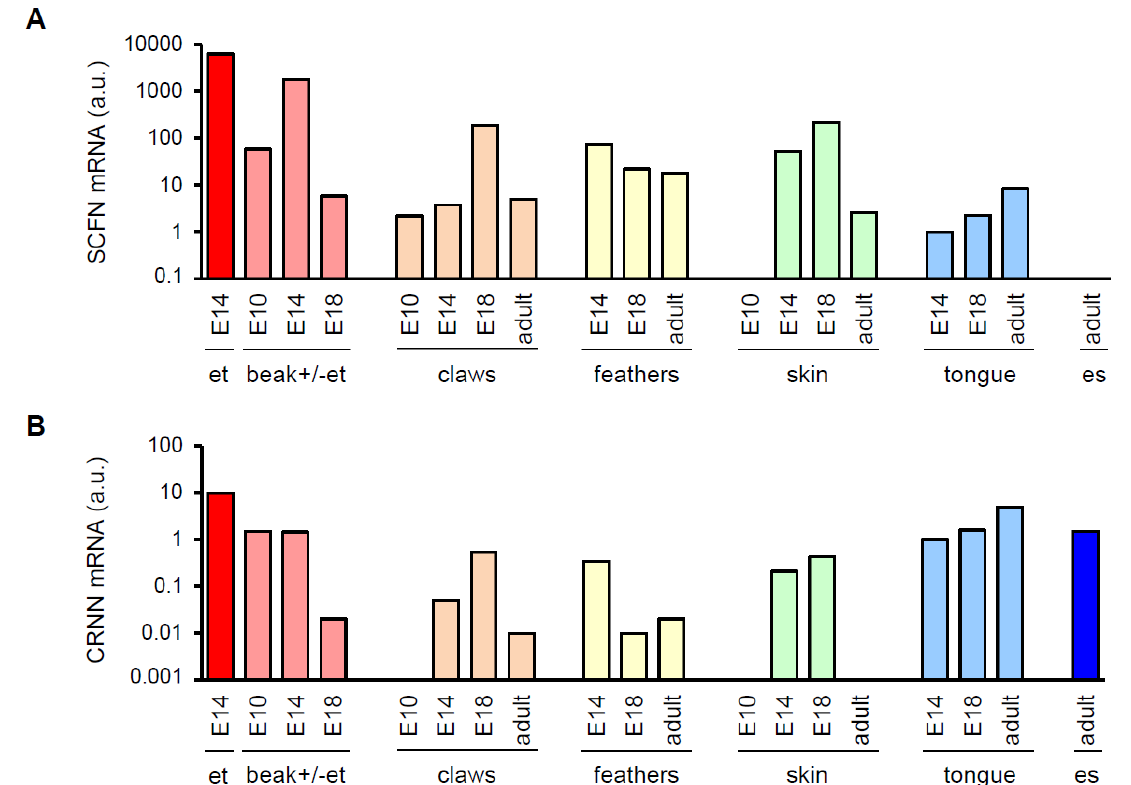
Figure 2. Expression of chicken SFTP mRNAs during embryonic development. RNA was extracted from indicated tissues of adult chicken and chicken embryos at developmental stages E10, E14 and E18. Following cDNA synthesis, real-time PCRs were performed. mRNA levels of SCFN ( A ) and CRNN ( B ) are shown in arbitrary units (a.u.) which were calculated by normalization to the housekeeping gene HPRT1 in the same tissue and dividing the normalized value of each tissue by the normalized expression level in the tongue sample of stage E14. At developmental stage E14, the beak of the embryo was separated into two different parts—the egg tooth (et) and the remaining beak. es, esophagus.